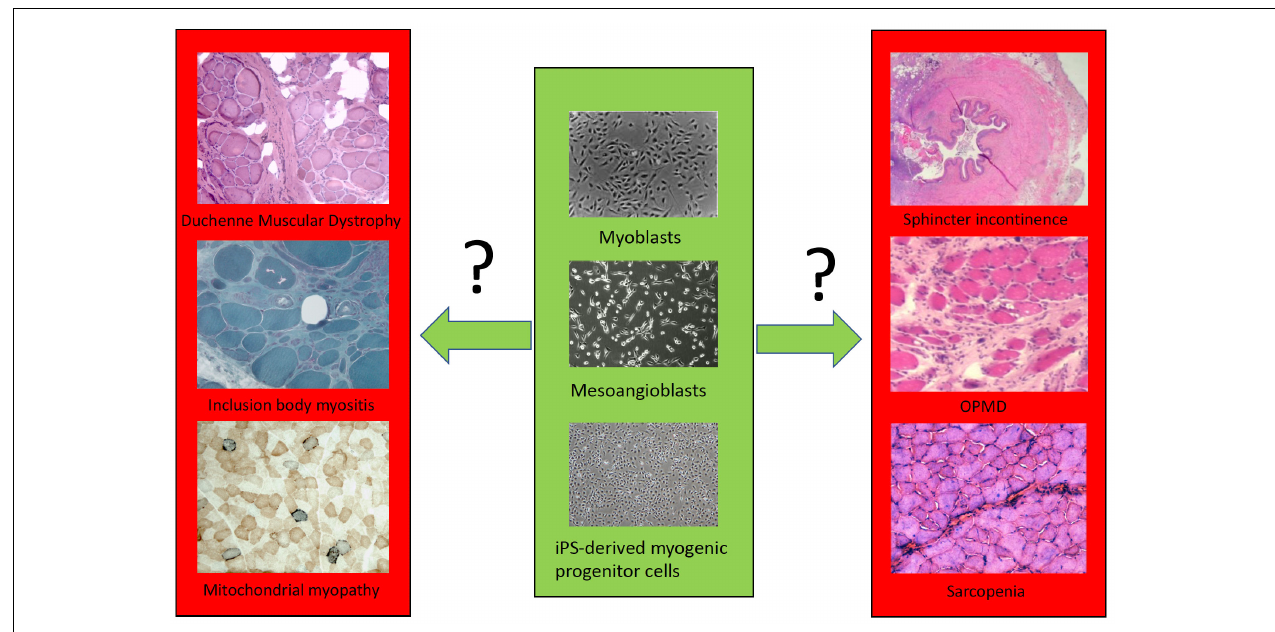
FIGURE 1 | A simplified scheme of the different cell types (only few examples are shown) available for transplantation in different muscle